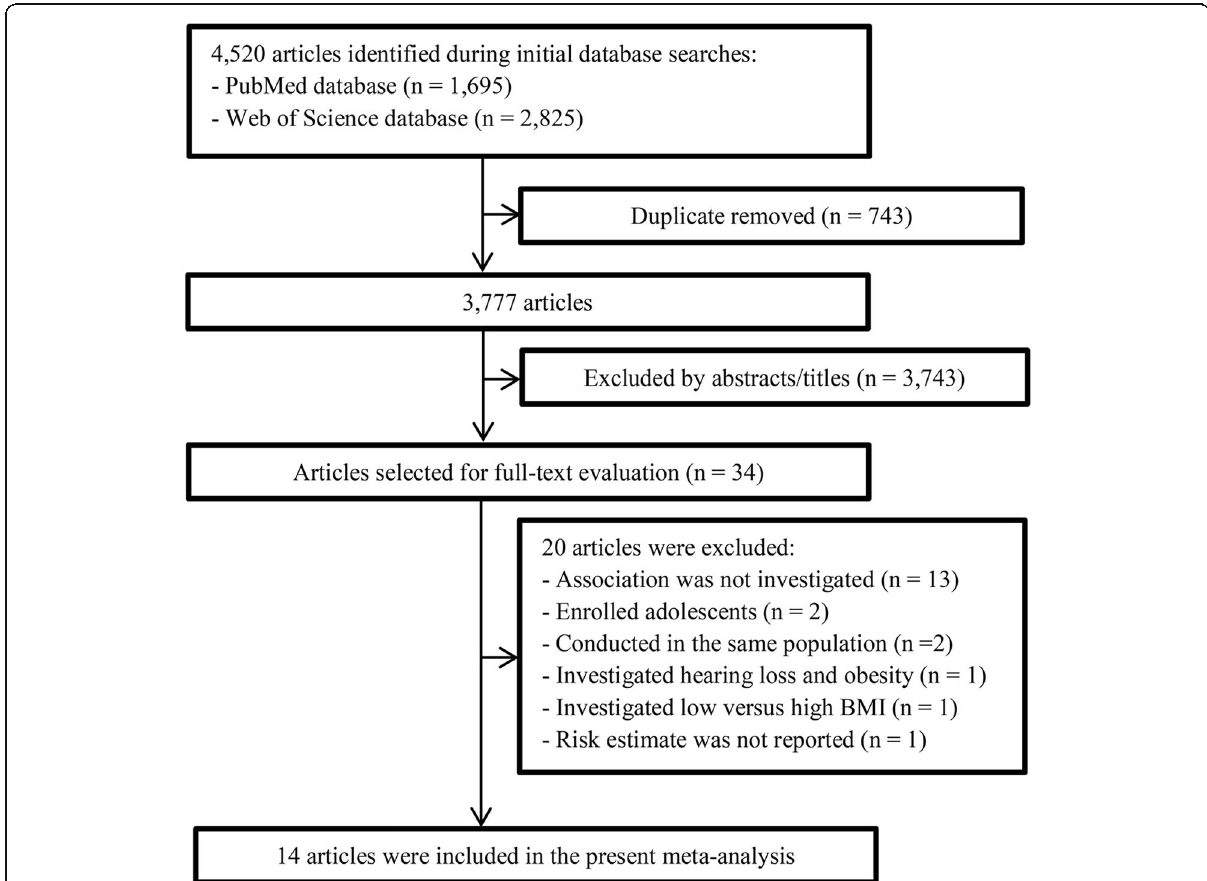
Fig. 1 Flow-chart of the study selection